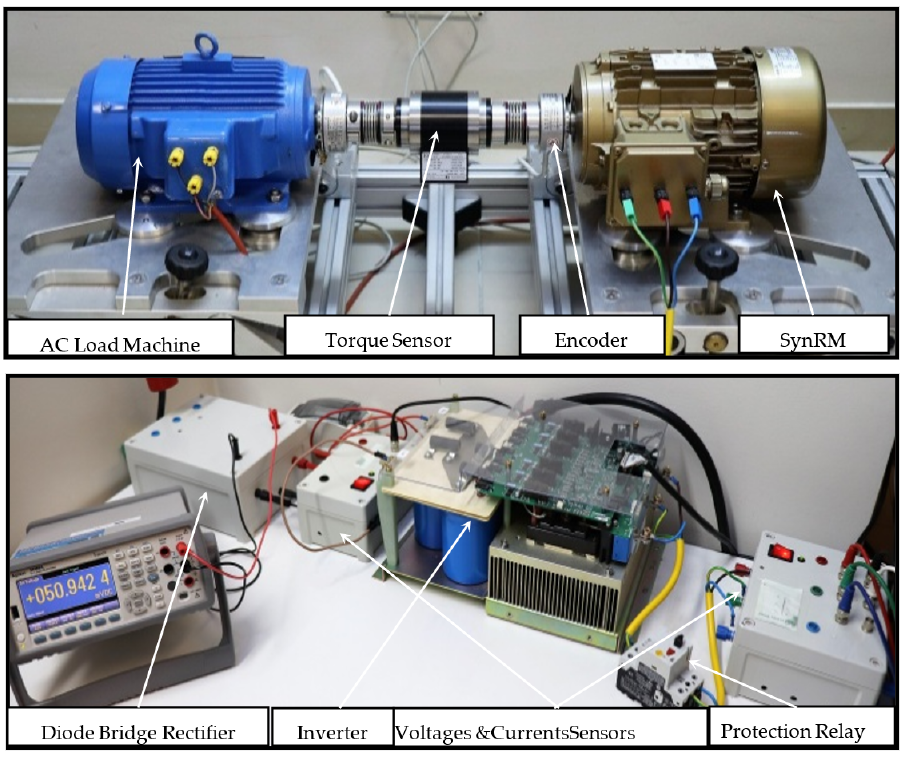
Figure 4. Experimental configuration of the SynRM drive. Table 3. Parameters of the used